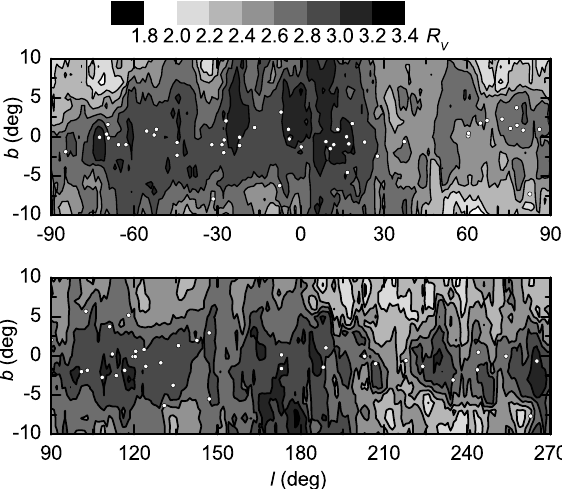
Fig. 1. 2D map of the distribution of the parameter R V . Empty circles mark the location of OB associations (Ruprecht